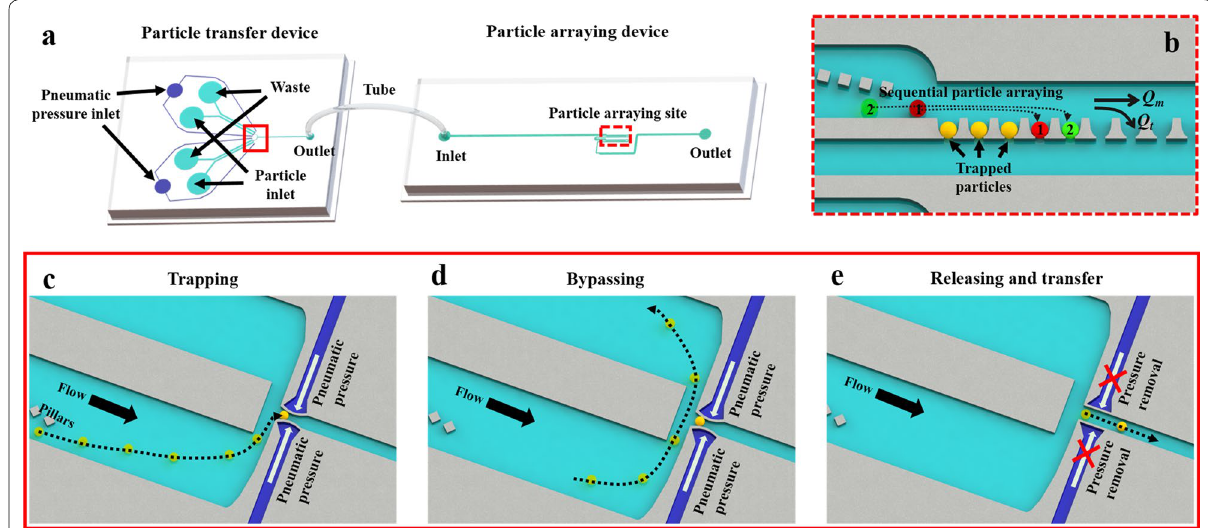
Fig. 1 Device design and operation mechanism. a Schematic illustration of the particle transfer device and particle arraying device. b Sequential particle arraying mechanism. Incoming particles are sequentially arrayed at each vacant trap site based on flow fractionation. c Single particle trapping by pneumatic microvalve operation. Channel wall is deflected by applied pneumatic pressure and it can trap a single particle. d Once a single particle is trapped, subsequent particles bypass the trap and migrate toward the waste. e Trapped single particle can be released by removal of the applied pneumatic